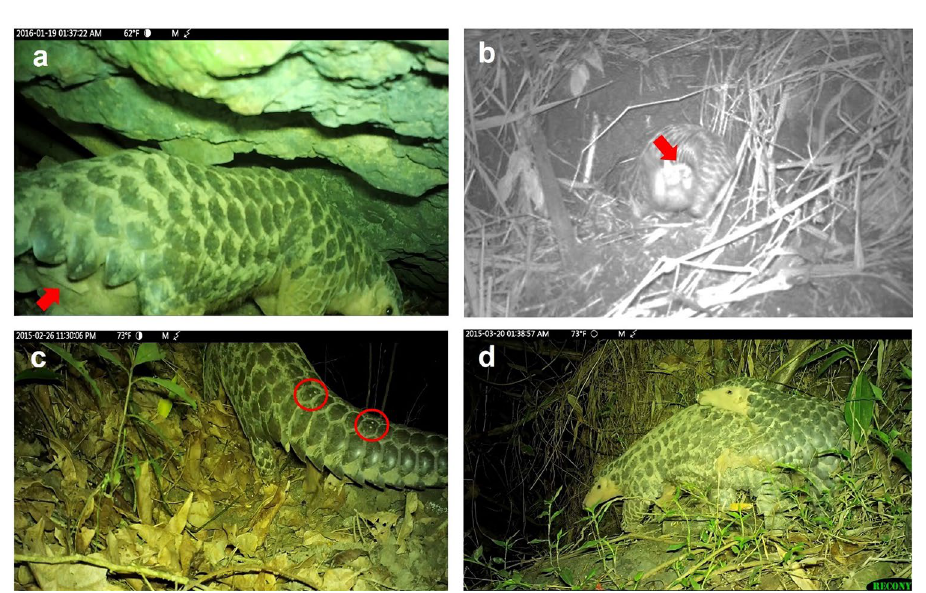
Figure 6. Male Chinese pangolins Manis pentadactyla visit the nursing burrows of a female pangolin. Two unknown individuals ( a , b ) were identified as males by the genitals, and one known male LM15 was identified by the scale mark ( c ). The female mated with an unknown male on 20 March 2015. The female was nursing a 4-month-old infant pangolin at the time ( d